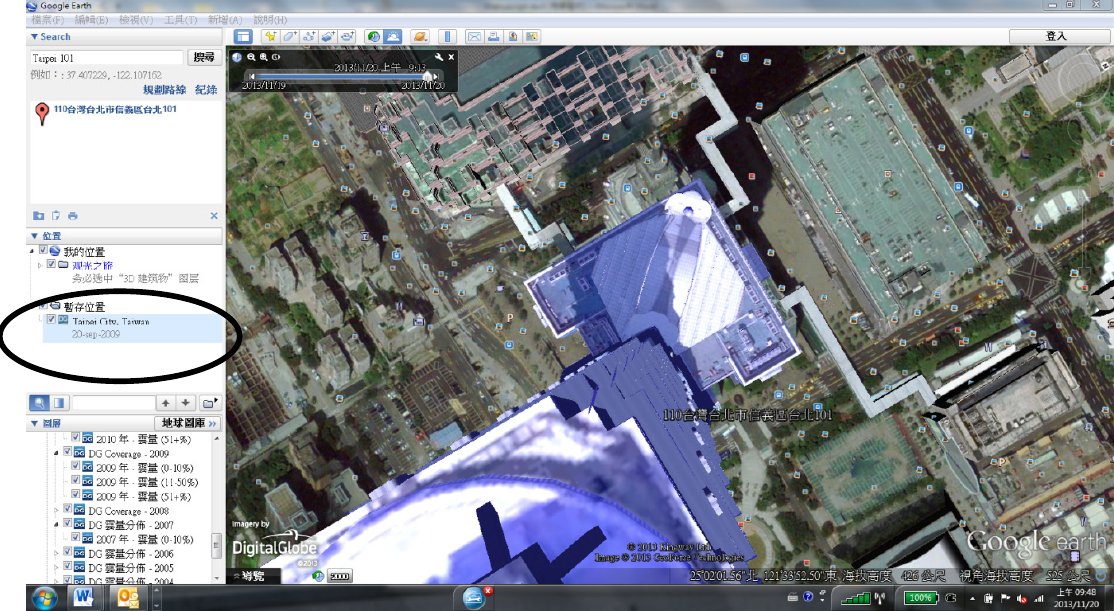
Figure A4. Tool box window of Digital Global view for observation of the